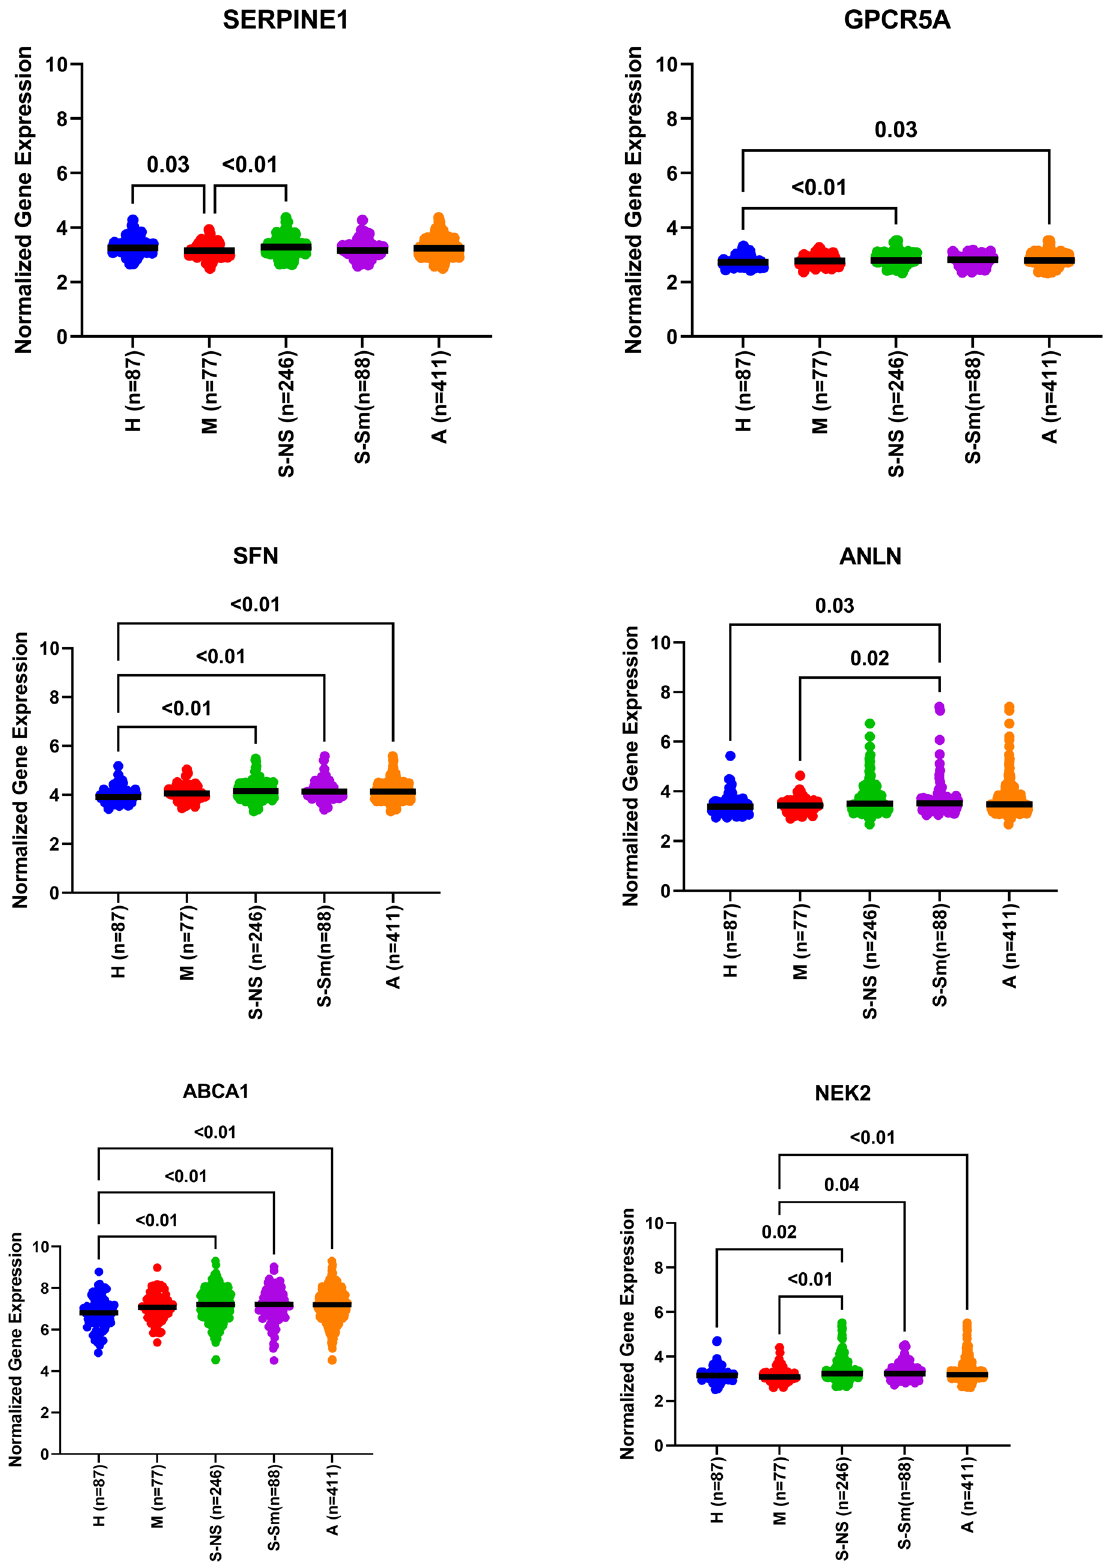
Figure 6. Normalized gene expression of genes identified in the blood of asthmatic patients compared to healthy controls extracted from the expression profile of publicly available datasets (GSE69683) collected in the U-BIOPRED study, where (H) represents the 87 healthy controls, (M) represents the 77-moderate asthma, (S) represents the 246 nonsmoker’s severe asthma, and 88 smoker’s severe asthma, (A) represents the sum of all asthmatic patients in all